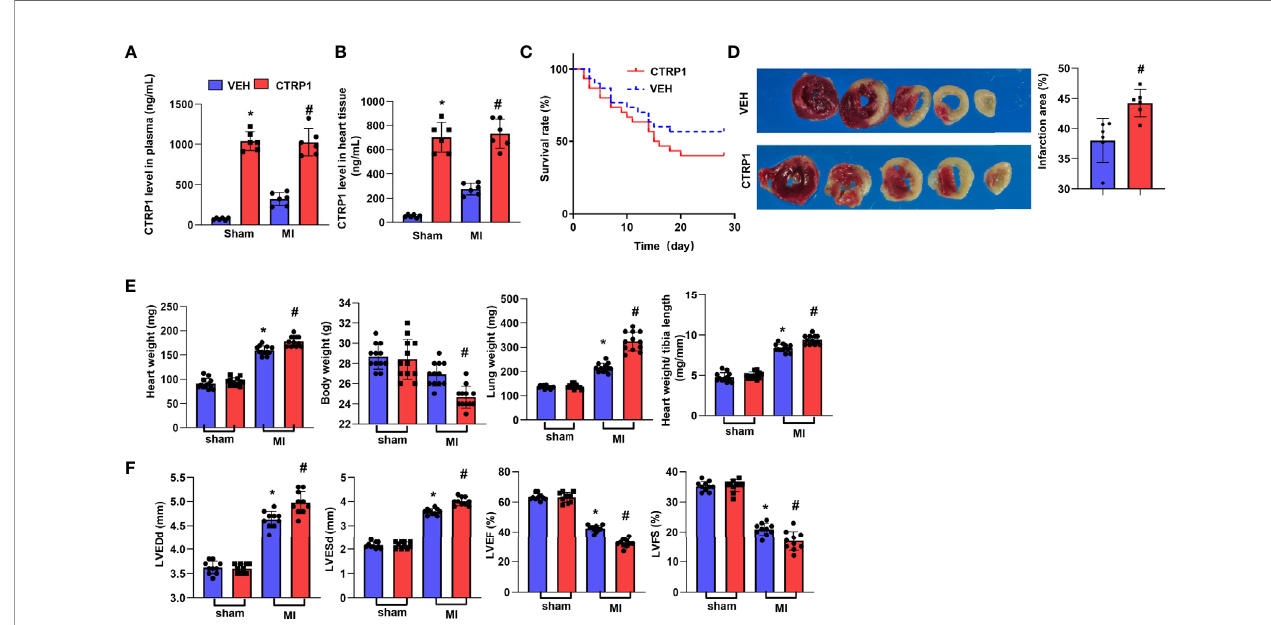
FIGURE 4 | Human recombinant CTRP1 ampli fi es cardiac dysfunction post MI. (A) Human CTRP1 protein level in mouse plasma 3 weeks after injection detected by Elisa (n=6). (B) Human CTRP1 level in mouse heart tissue 3 weeks after injection detected by Elisa (n=6) (C) The survival rate of mice receiving the human recombinant CTRP1 protein at 28 days post MI (n=30 per group). (D) TTC staining and quanti fi cation of the infarct area (n=6). (E) Heart, body, and lung weights of mice at 28 days post MI (n=12). (F) Echocardiography of mice at 28 days post MI (n=10). * P <0.05 vs. the VEH-sham group. # P <0.05 vs. the VEH-MI